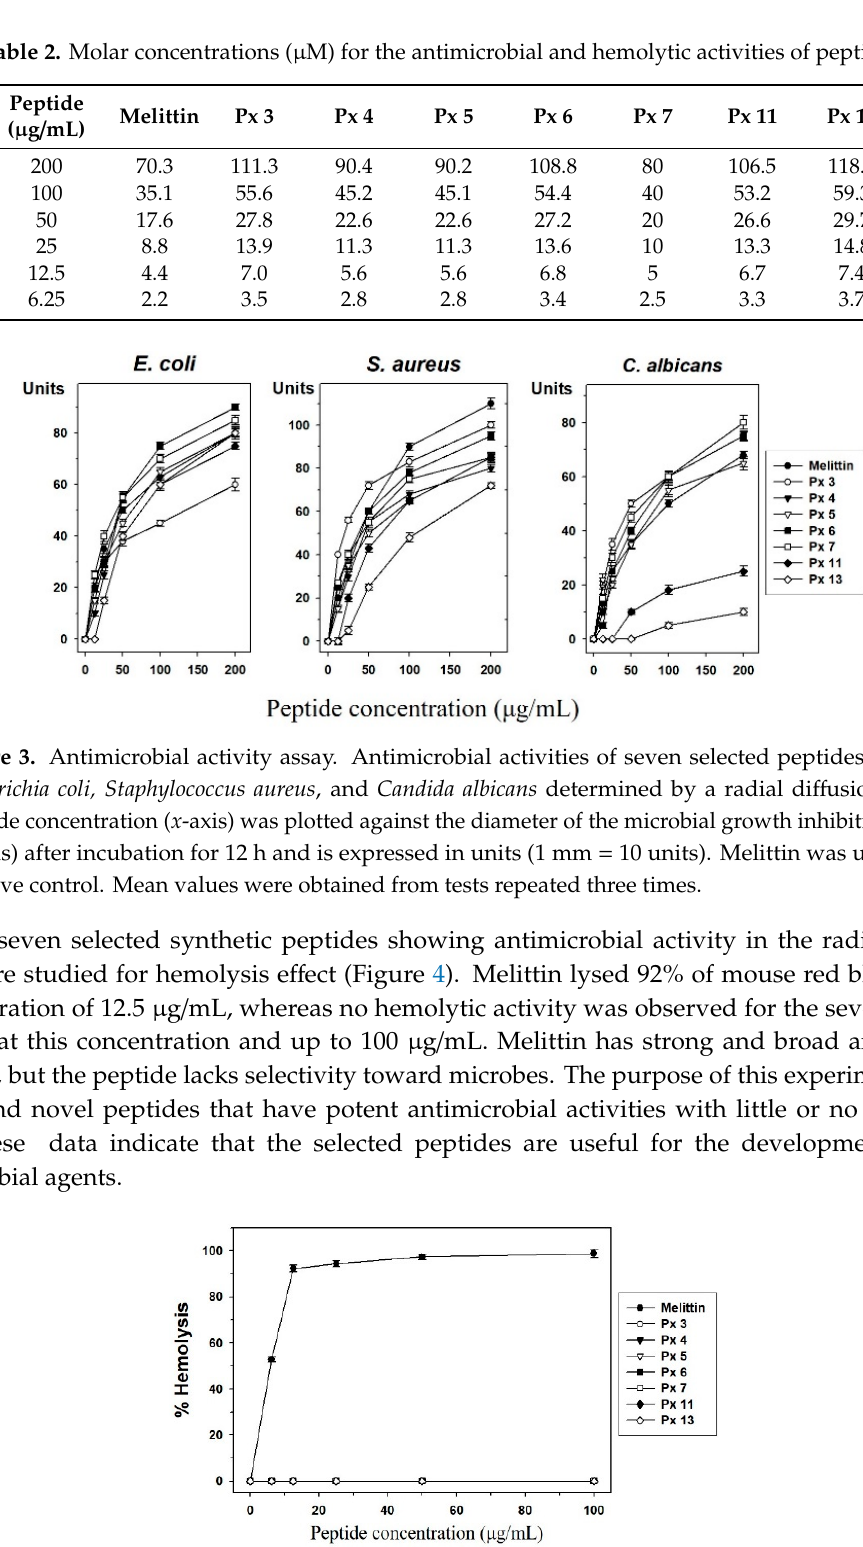
Figure 4. Hemolytic activity of the seven selected peptides. Peptide concentration ( x -axis) was plotted against the percentage of hemolysis ( y -axis) of mouse red blood cells after incubation for 30 min. Melittin was used as the positive control. The percent hemolysis was calculated with the following equation: hemolysis (%) = (A 540 of sample − A 540 of peptide-free control) / (A 540 of 100% control − A 540 of peptide-free control) × 100. Each symbol represents the mean value estimated from triplicate